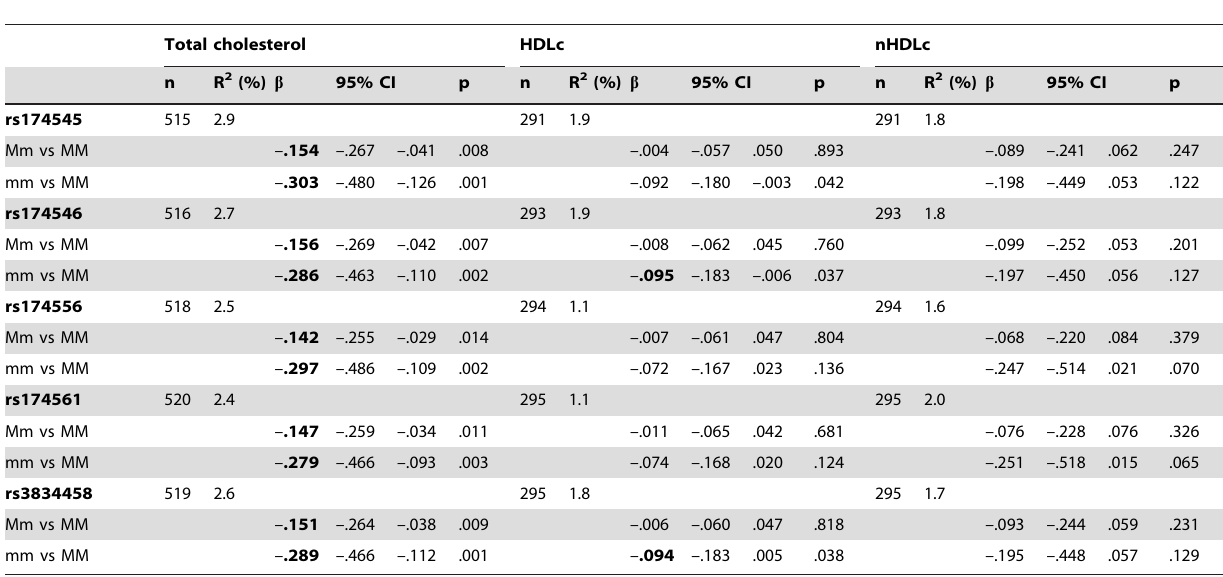
Table 6. Associations between FADS gene variants and total cholesterol, HDLc, and nHDLc (model 1 according to Table 2).